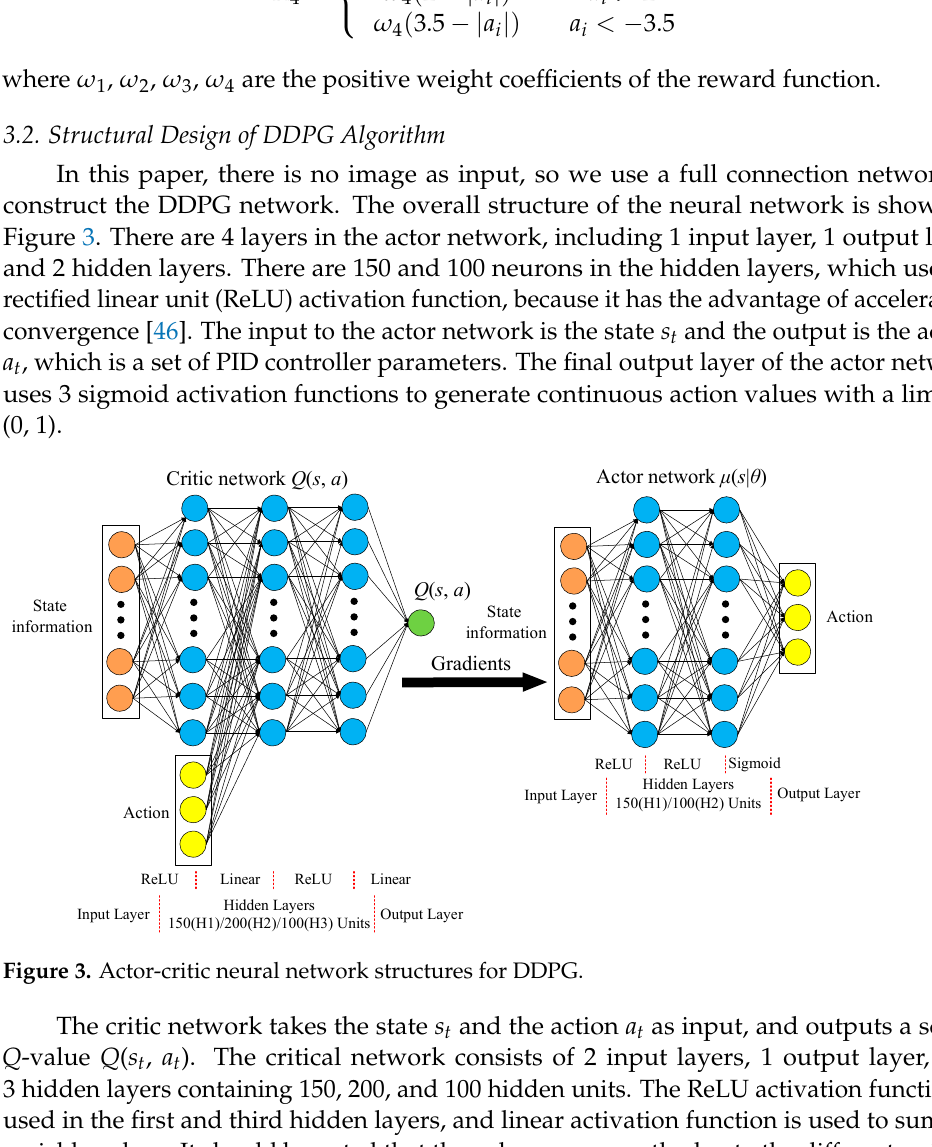
Table 1. Training parameter settings.